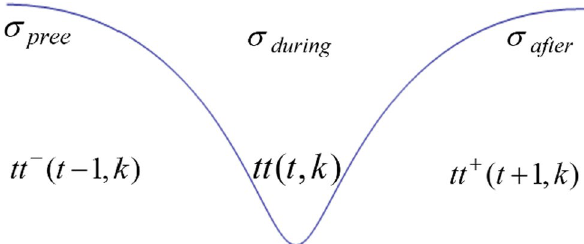
Fig. 3 Standard deviations of traffic flow before and after an abnormal